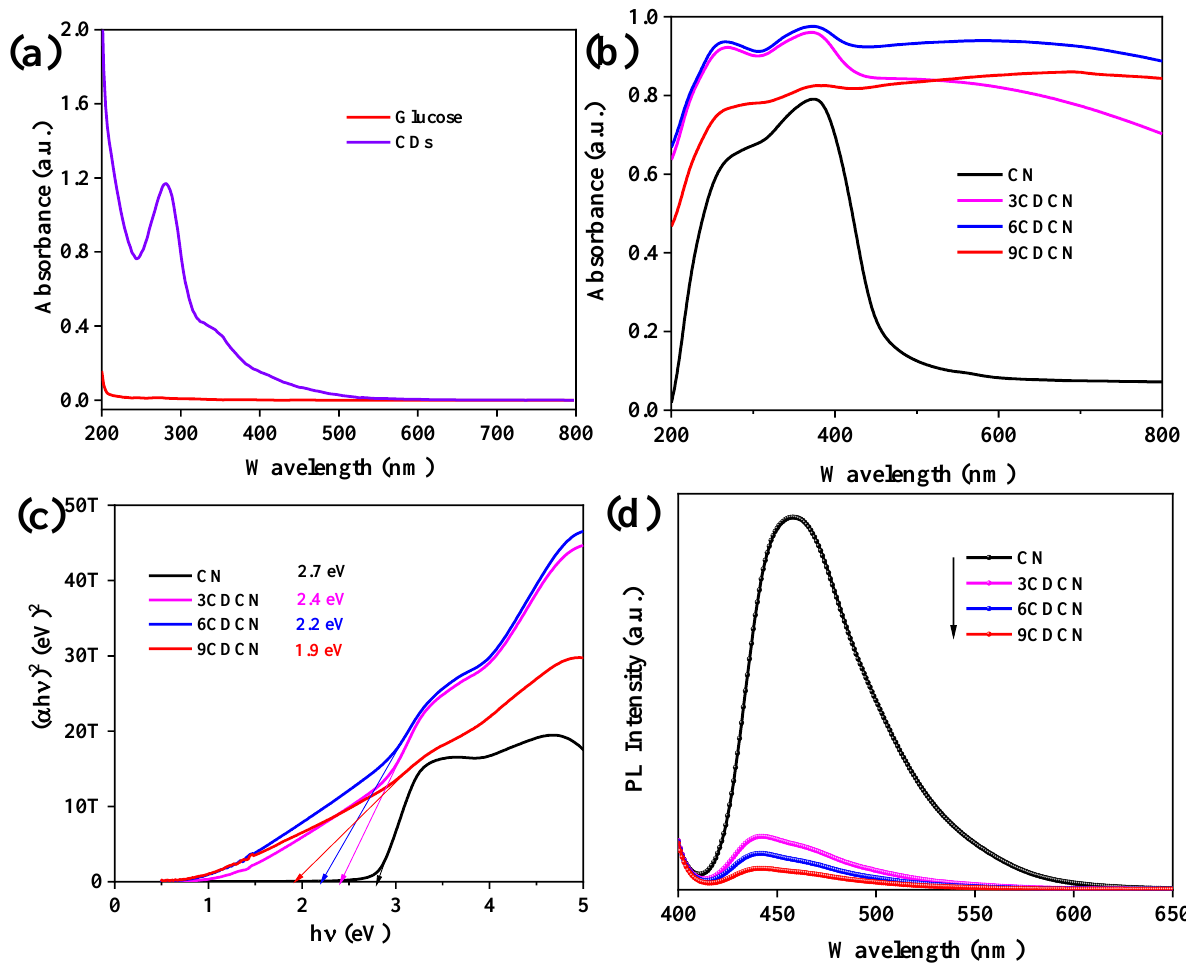
Figure 5. ( a ) UV absorption spectra of glucose and CDs. Prepared nanomaterials: CN, 3CDCN, 6CDCN, and 9CDCN. ( b ) UV-vis DRS spectra, ( c ) band gap, and ( d ) PL spectra.